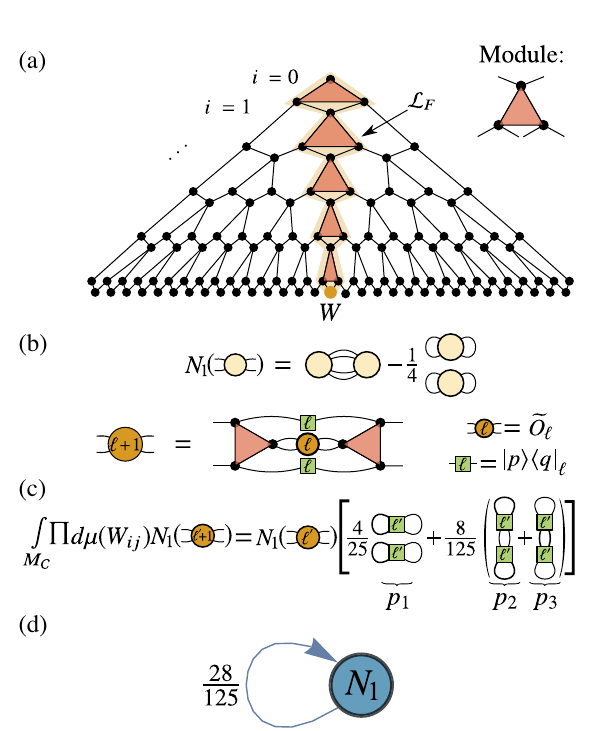
FIG. 5. GRIM for the case when W is in the center of l th layer of the QCNN. (a) The unitaries in L can be covered by l center F modules M C . (b) Schematic representation of the tensor con- traction N 1 of Eq. (19). Here we also show the recursive relation ˜ O l . (c) Tensor network representation of between the operators Eq. (25) obtained by integrating the ð l 0 þ 1 Þ th center module. The operators p 2 and p 3 correspond to contractions over different qubits, as indicated by the bold lines. (d) Graph G obtained from w the GRIM for the case in